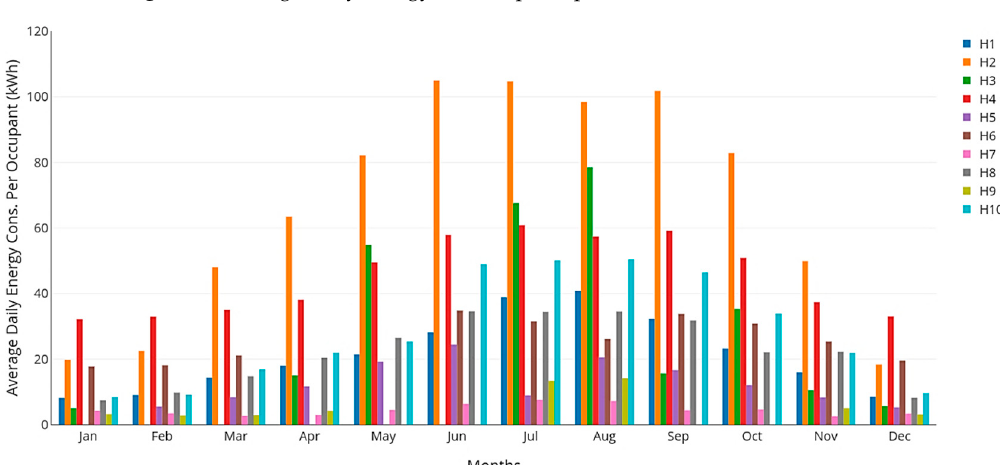
Figure 8. Average daily energy consumption per occupant per month for houses H1–H10.